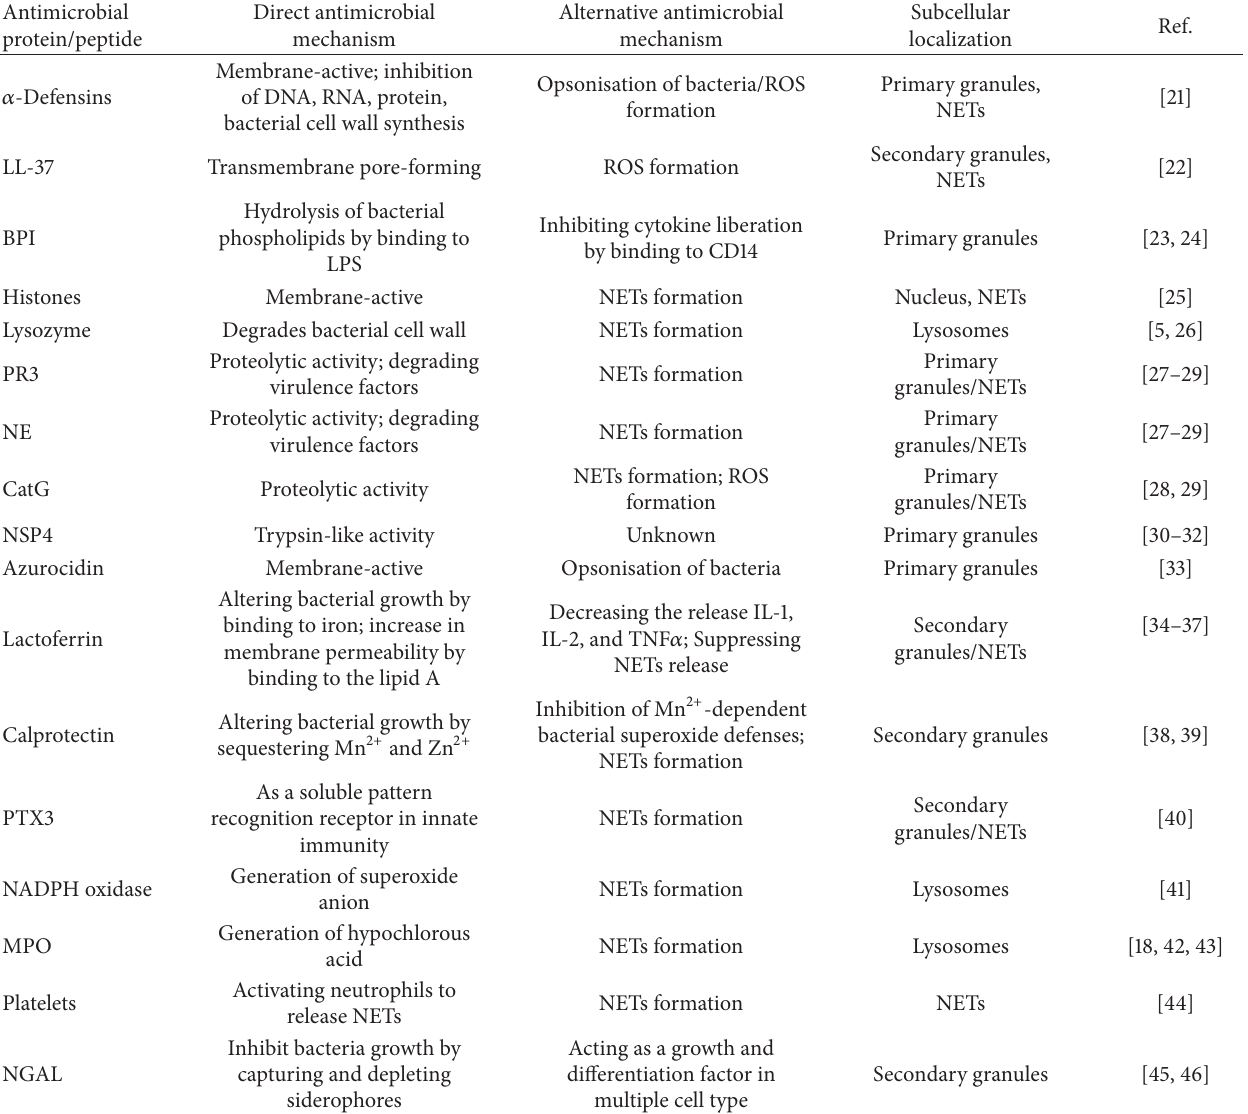
Table 1: Mechanism of action of neutrophil antimicrobial